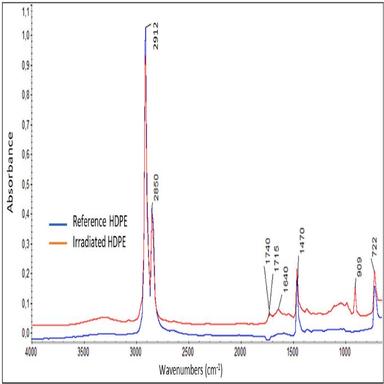
FTIR analysis: comparison between spectra of reference and 10% irradiated HDPE.